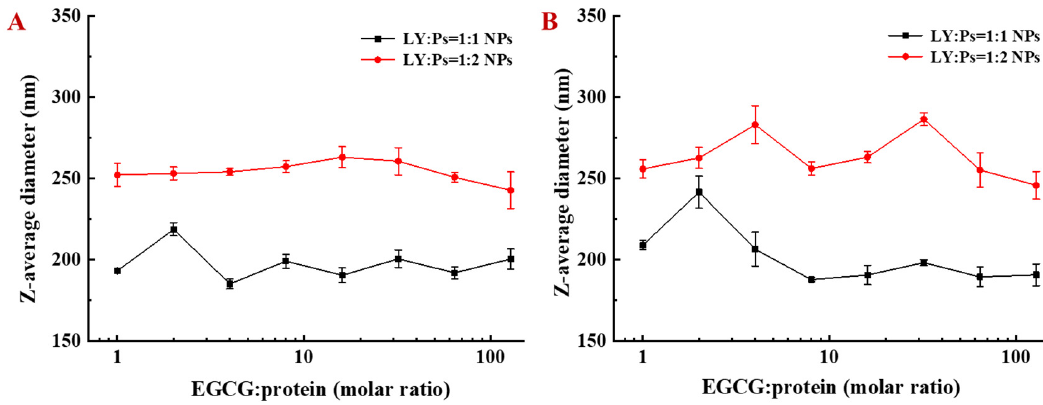
Figure 6. Particle size changes of lysozyme-pectin nanoparticles after ( A ) 0 h and ( B ) 24 h storage at room temperature.